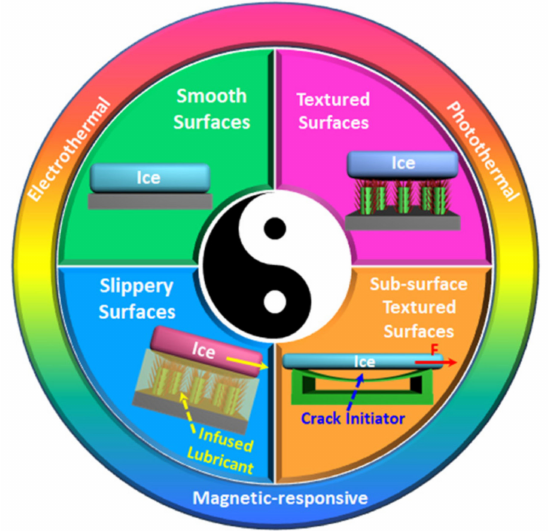
Figure 13. Multiple passive anti-icing combined strategies (i.e., smooth surfaces, textured surfaces, slippery surfaces and sub-surface textured surfaces) promoted by low ice adhesion surfaces. Active approaches (i.e., electro-thermal, photo-thermal and magnetic-responsive stimulus) can also be combined with passive anti-icing strategies for designing new icephobic surfaces in